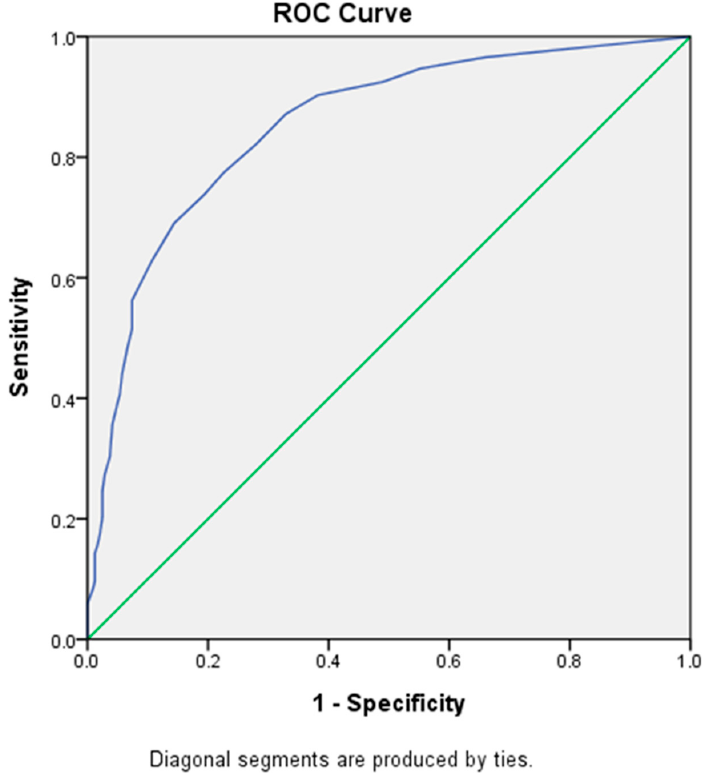
Figure 2. Receiver Operating Characteristic (ROC) curve of LDQ scores predictive of MOH. Abbreviations: LDQ = Leeds Dependence Questionnaire, MOH = medication-overuse headache.